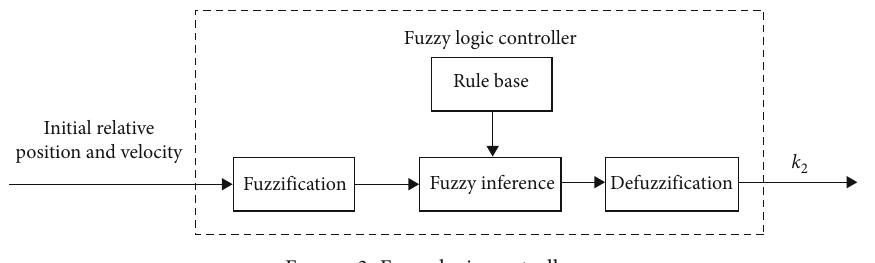
Figure 3: Fuzzy logic controller. Table 1: Rule base as a 7 × 7 look-up